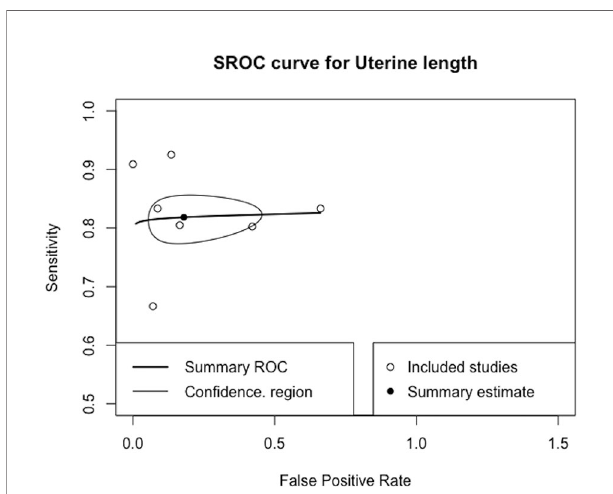
FIGURE 5 | SROC curve of uterine length. SROC, summary receiver operating characteristic.